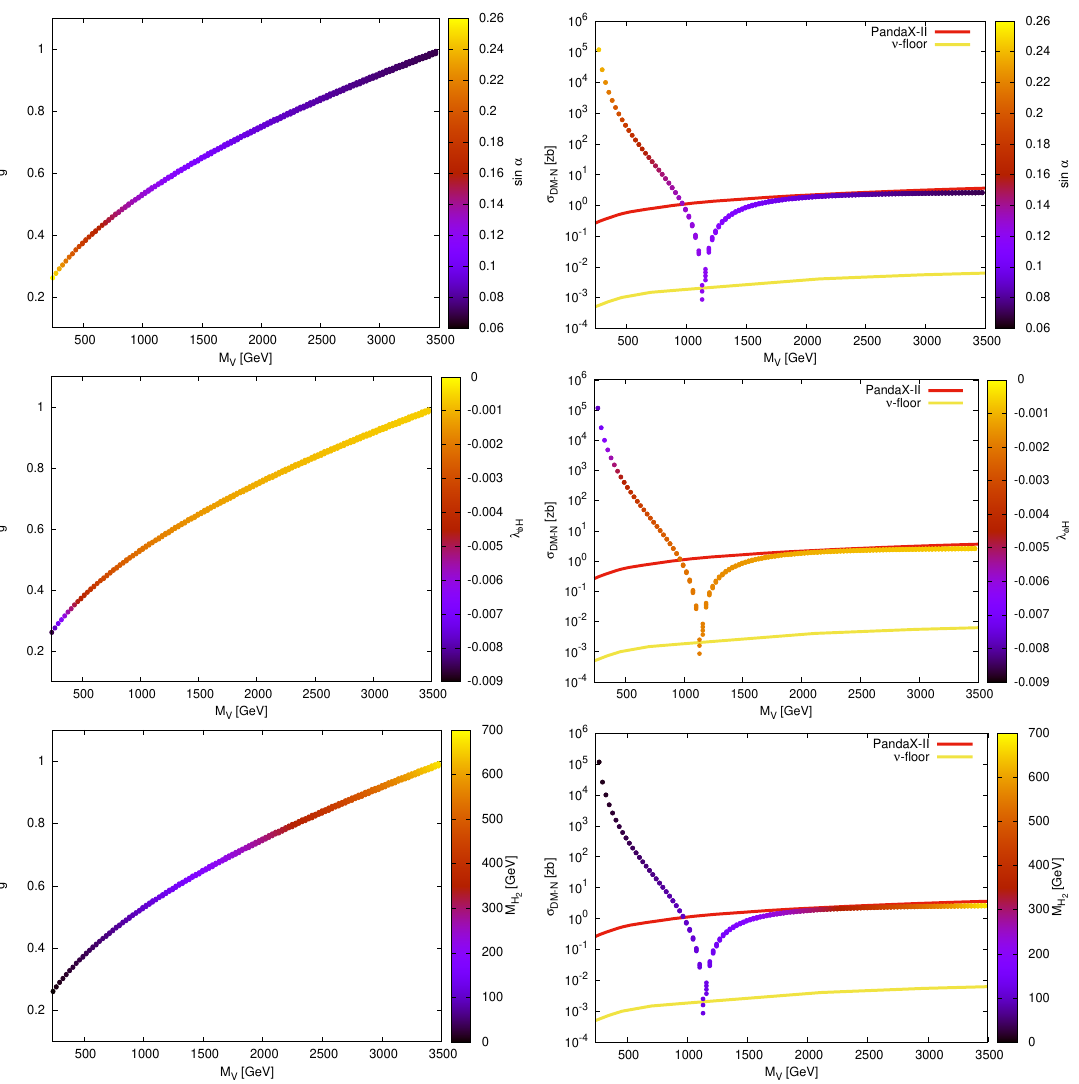
Figure 5 . (Left) Ranges of parameters space of the model in M V and g plane which are consistent with observed relic density by Planck collaboration. (Right) DM-nucleon cross section as function of DM